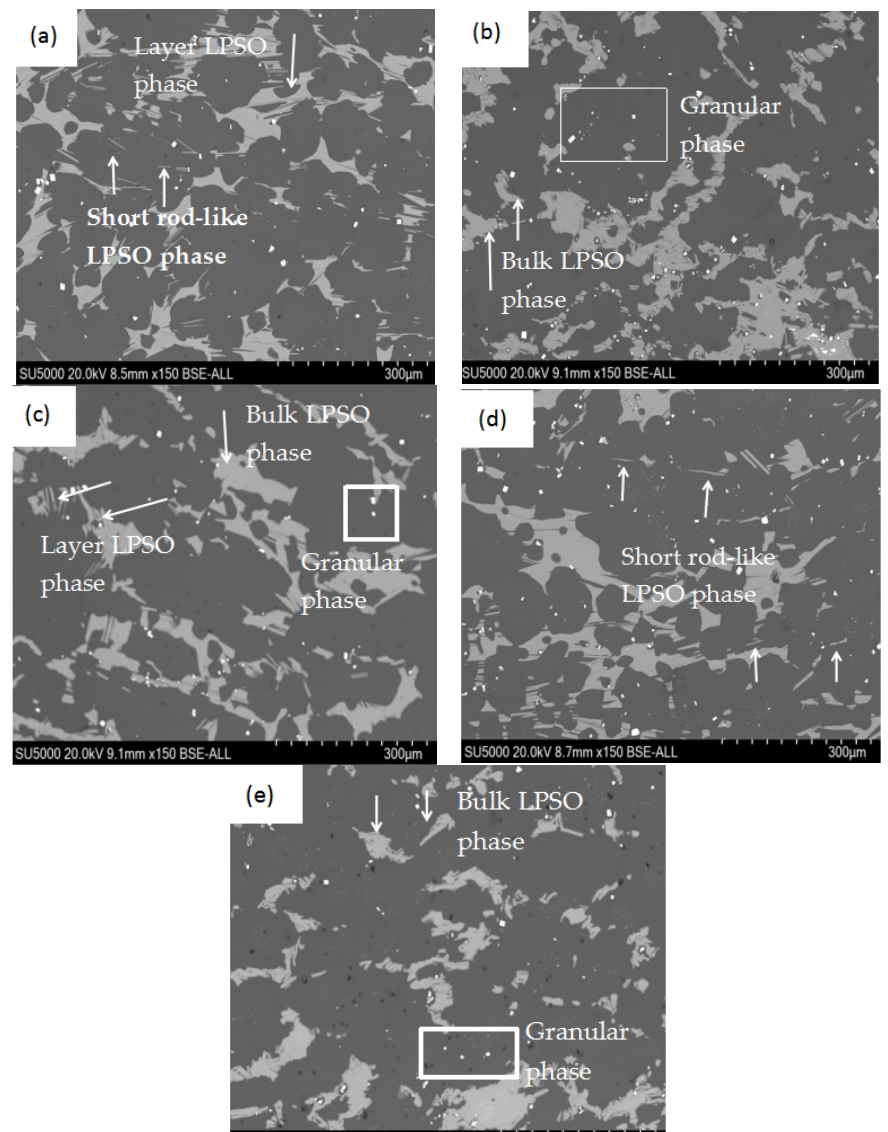
Figure 18. SEM microstructure of samples 1–5.( a ) Sample 1; ( b ) Sample 2; ( c ) Sample 3; ( d ) Sample 4; ( e ) Sample 5.